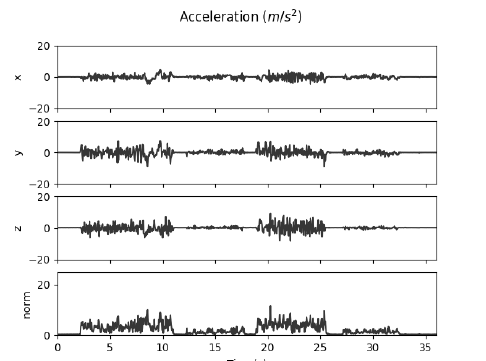
Figure 9. Vibration level of module (Normal, 30cm)